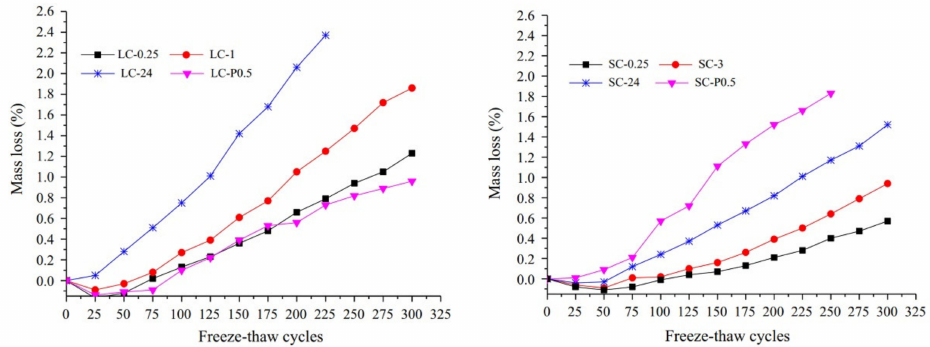
Figure 14. E ff ect of aggregate saturation degree on mass loss [118], with copyright from